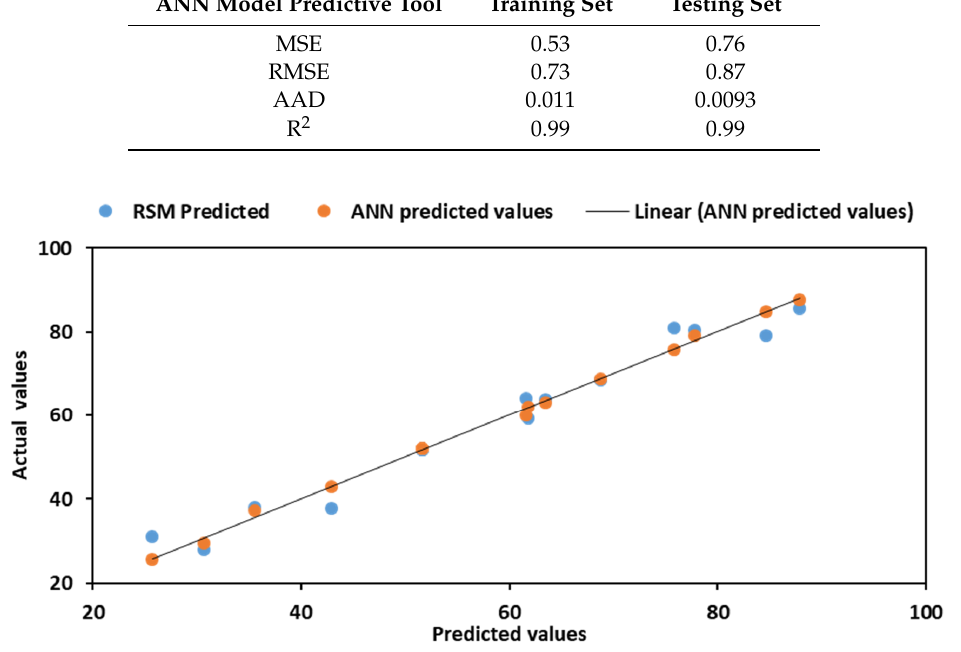
Figure 5. Parity plots of RSM and ANN predictions for sulphate removal in the treatment of South African acid mine drainage. African acid mine Table 4. ANN model predictive measurements for model fit in the training and testing sets.